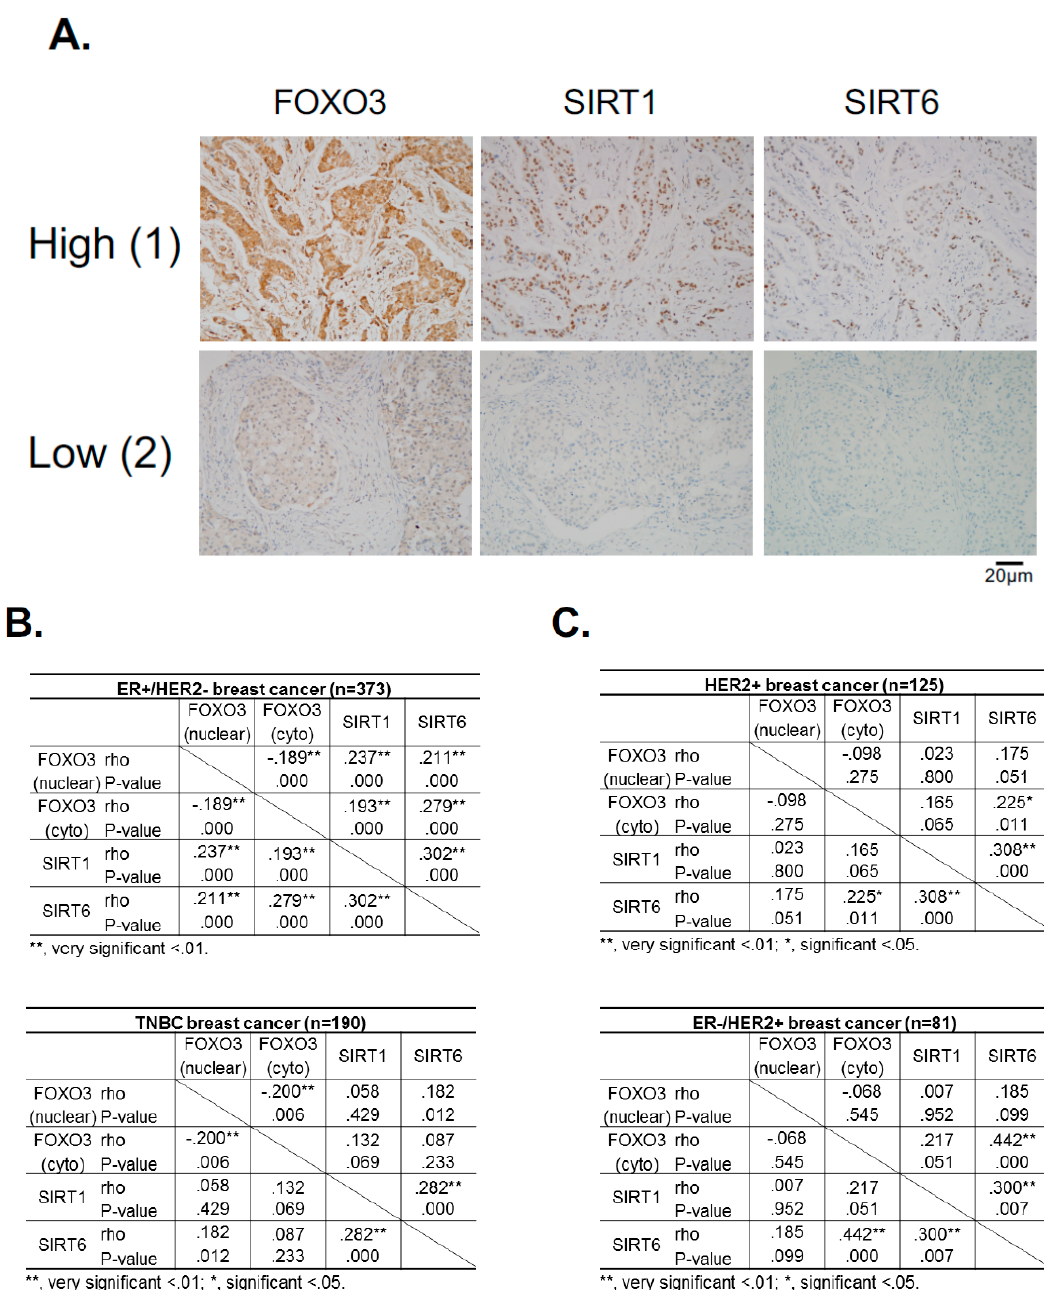
Figure 8. FOXO3 expression correlates with SIRT6 and SIRT1 levels in different breast cancer subtypes. ( A ) Representative immunohistochemical staining images from two samples (patient 1 and 2) showing correlations between FOXO3, SIRT1 and SIRT6 expression. Scale bar: 20 µm. ( B , C ) Staining results and Chi-square analysis. Chi-square statistical analysis was used to test the correlations between FOXO3, SIRT1 and SIRT6 expression in patients using SPSS 16.0. In statistical analysis, p < 0.05 was considered as significant (* p < 0.05, ** p < 0.01).